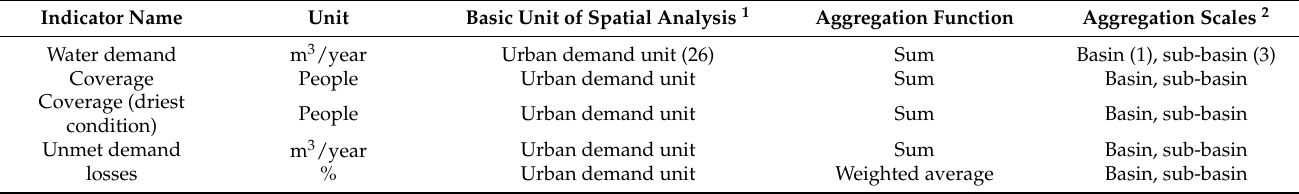
Figure 4. Conceptual design of the participatory decision-making model for the Rocha River Basin. Table 3. Multiscale indicators (M) to evaluate the performance of intervention actions.